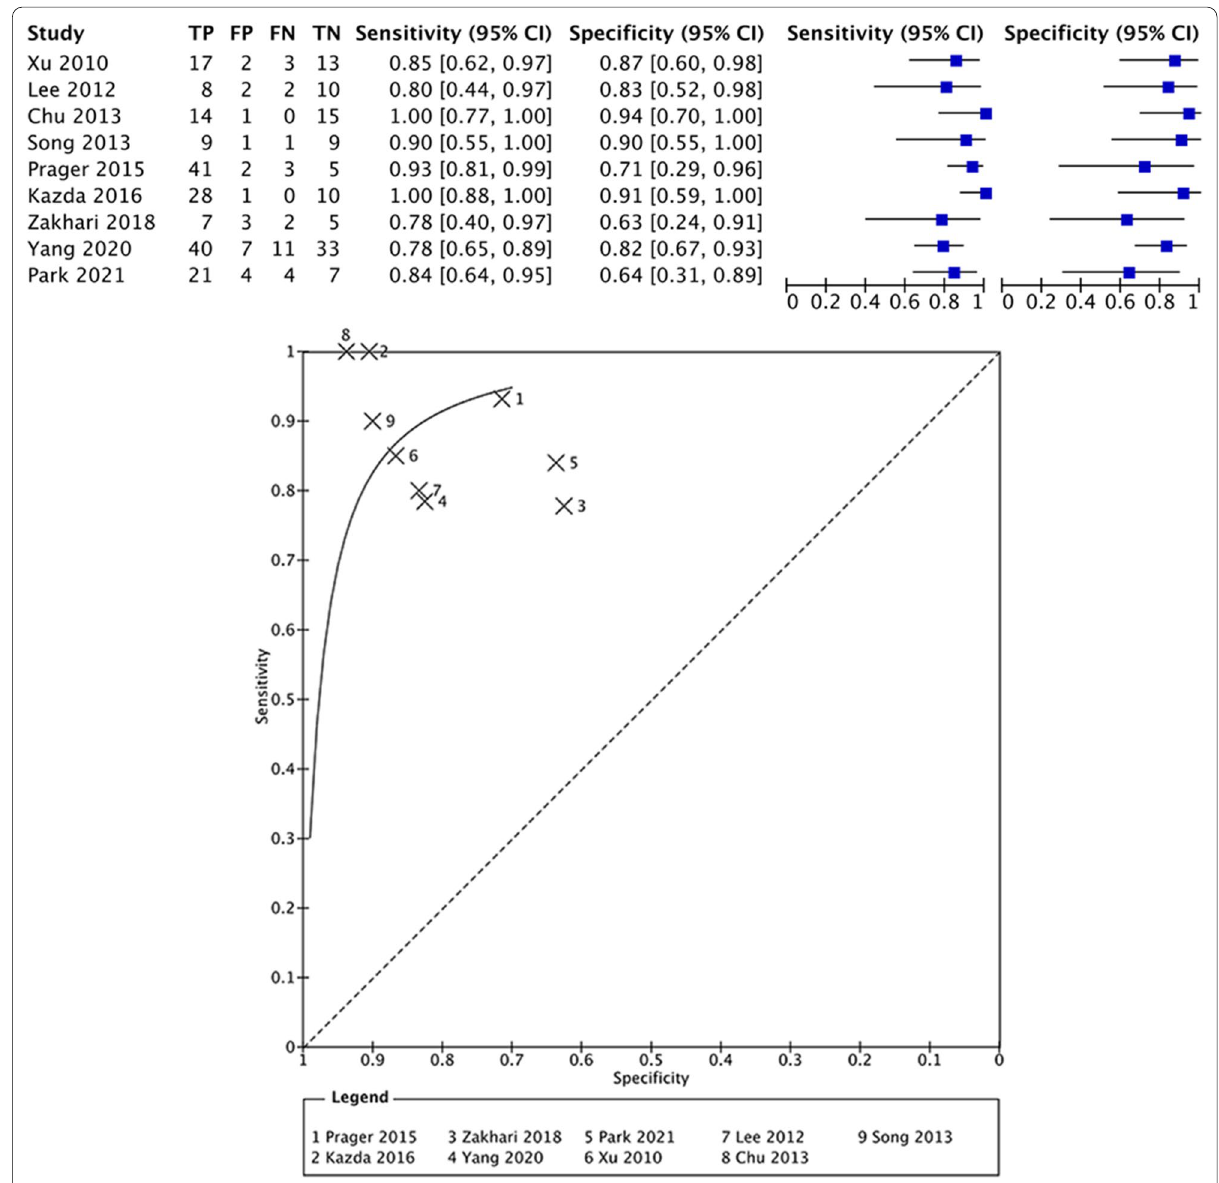
Fig. 4 Summary receiver operator characteristics plot of sensitivity and 1-specificity ratios of the included